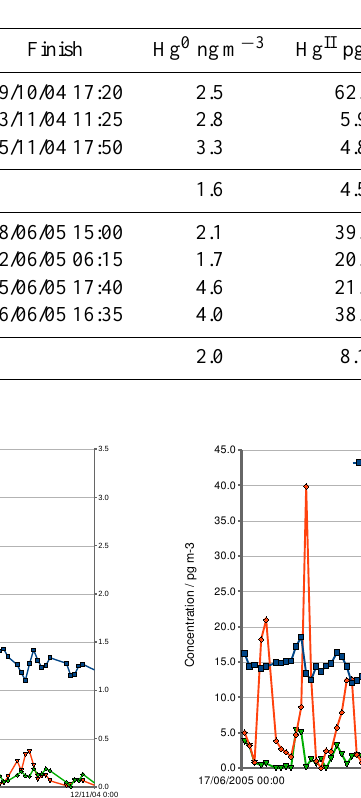
Table 1. The high Hg species concentration events.